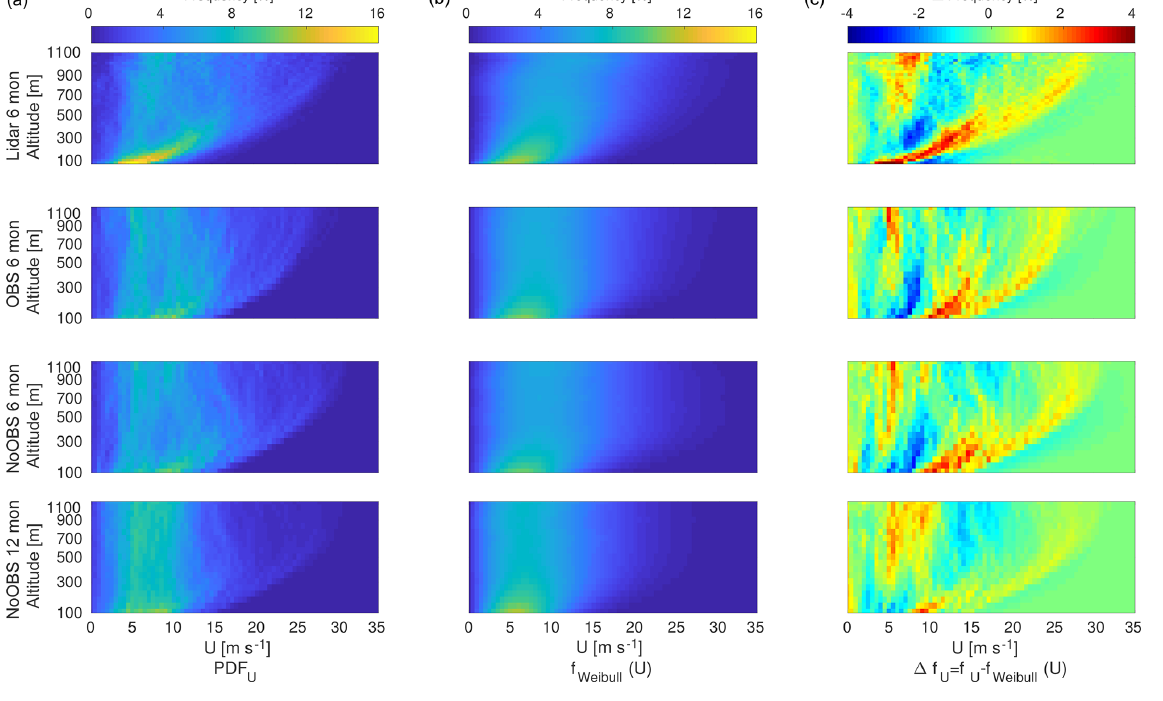
Figure 7. Frequency of occurrence (a) , Weibull fit (b) and difference between the two (c) for the 6-month lidar measurements (top row), 6-month OBS model (second row), 6-month NoOBS model (third row) and 12-month NoOBS (bottom row). All data (not filtered by lidar data availability) were used for the WRF data